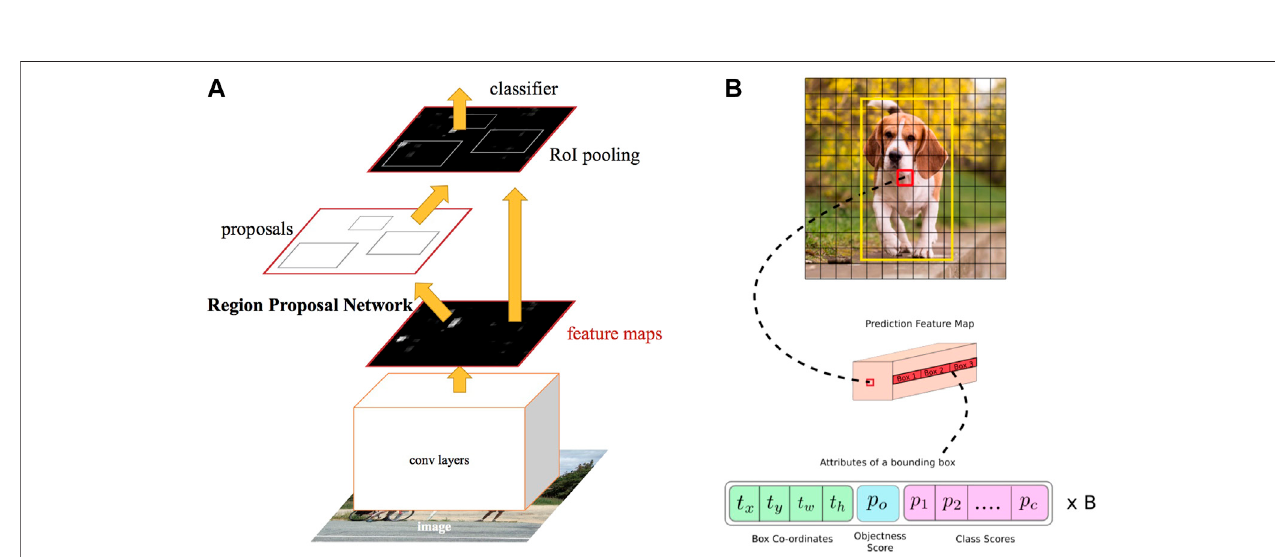
FIGURE 6 | Example of two-stage and single-stage detectors Kathuria (2021). (A) Two-stage detector (RCNN). (B) Single-stage detector (YOLO).